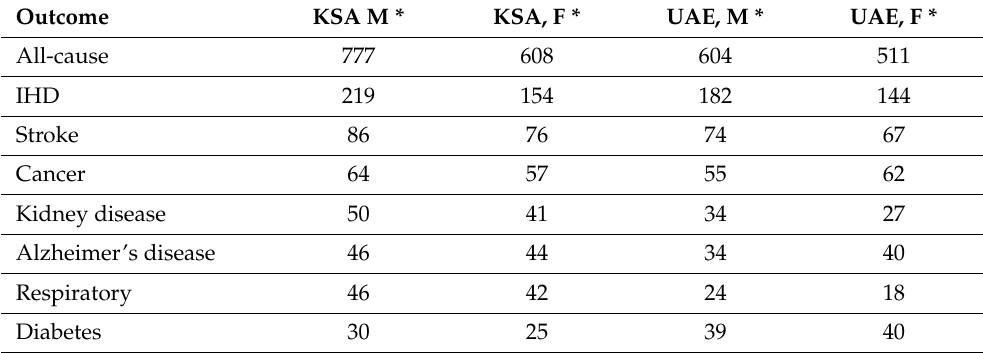
Table 1. Mortality rates in 2016 for KSA and the UAE